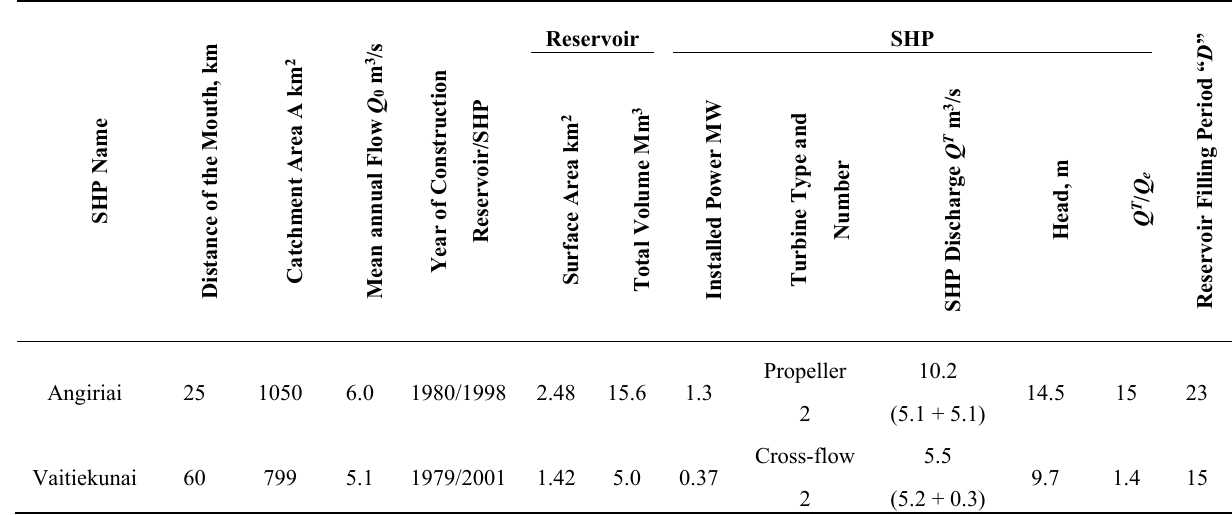
Table 3. Description of reservoirs and SHPs on the Susve River.